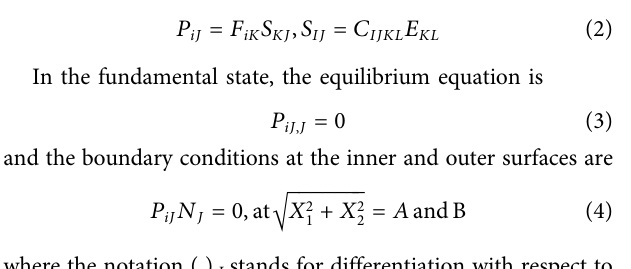
Frontiers in Mechanical Engineering |